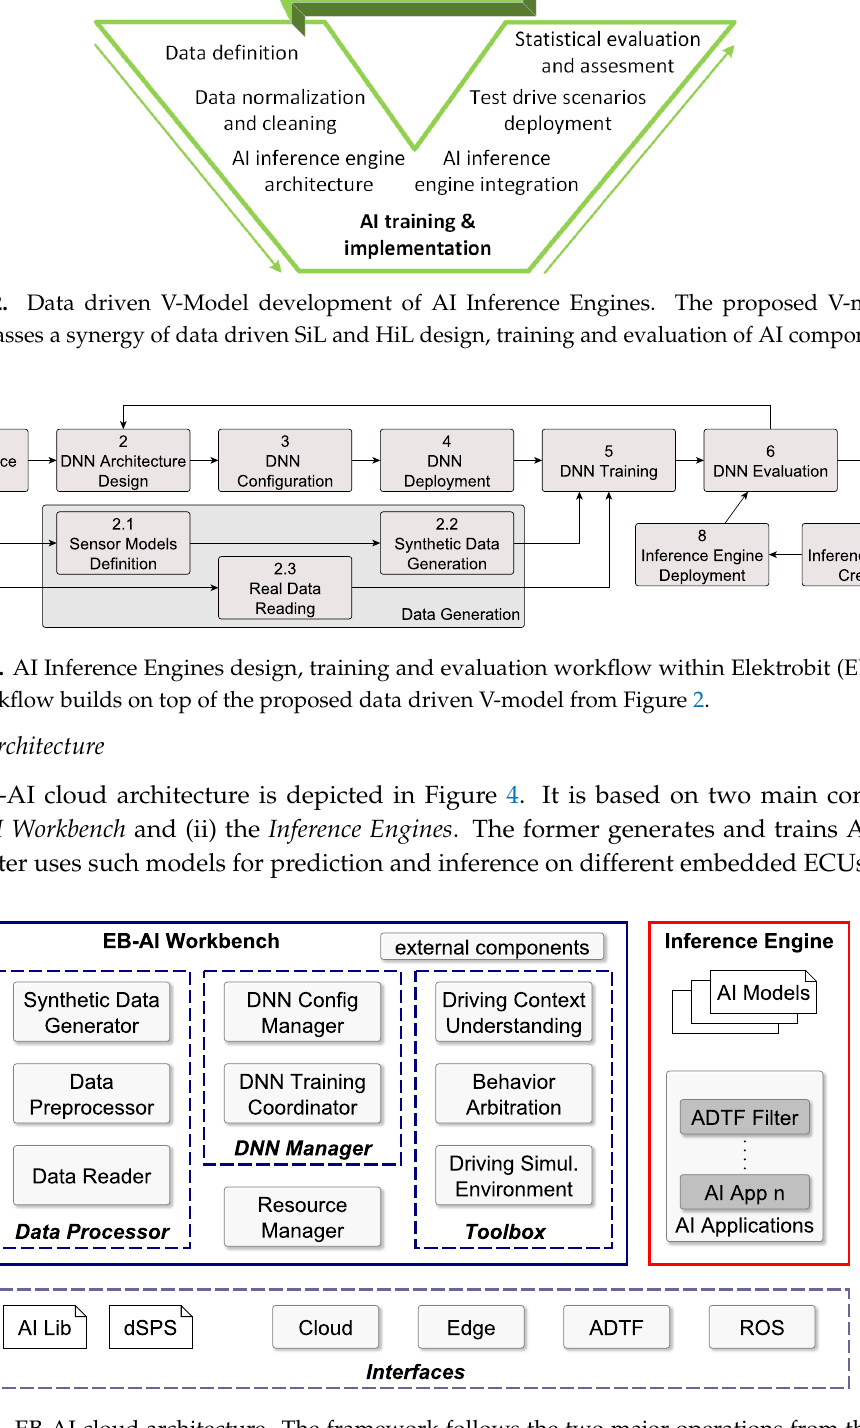
Figure 4. EB-AI cloud architecture. The framework follows the two major operations from the DL workflow: design and training in the EB-AI Workbench and inference. The interfaces allow for flexibility with respect to the core AI libraries, edge device hardware and type of application deployment